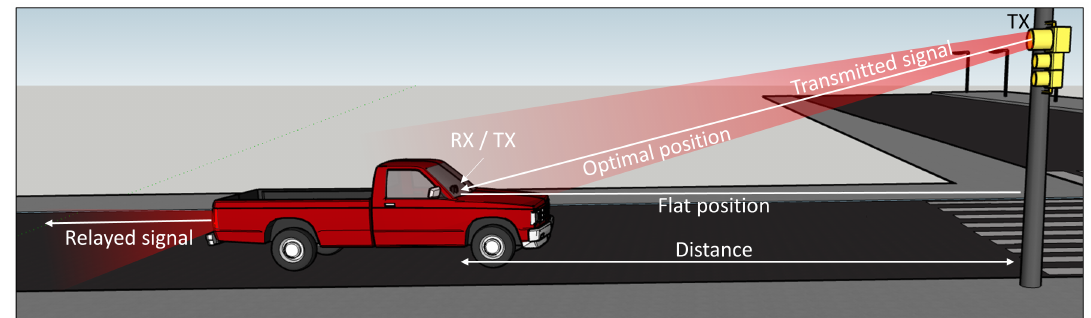
Figure 1. Proposed prototype for infrastructure-to-vehicle (I2V) communication: Traffic light transmits messages to the vehicle, which decodes and compares the message with a stored one and relays only if whole message is received correctly. Two configurations, Flat and Optimal are considered for performance analysis of the